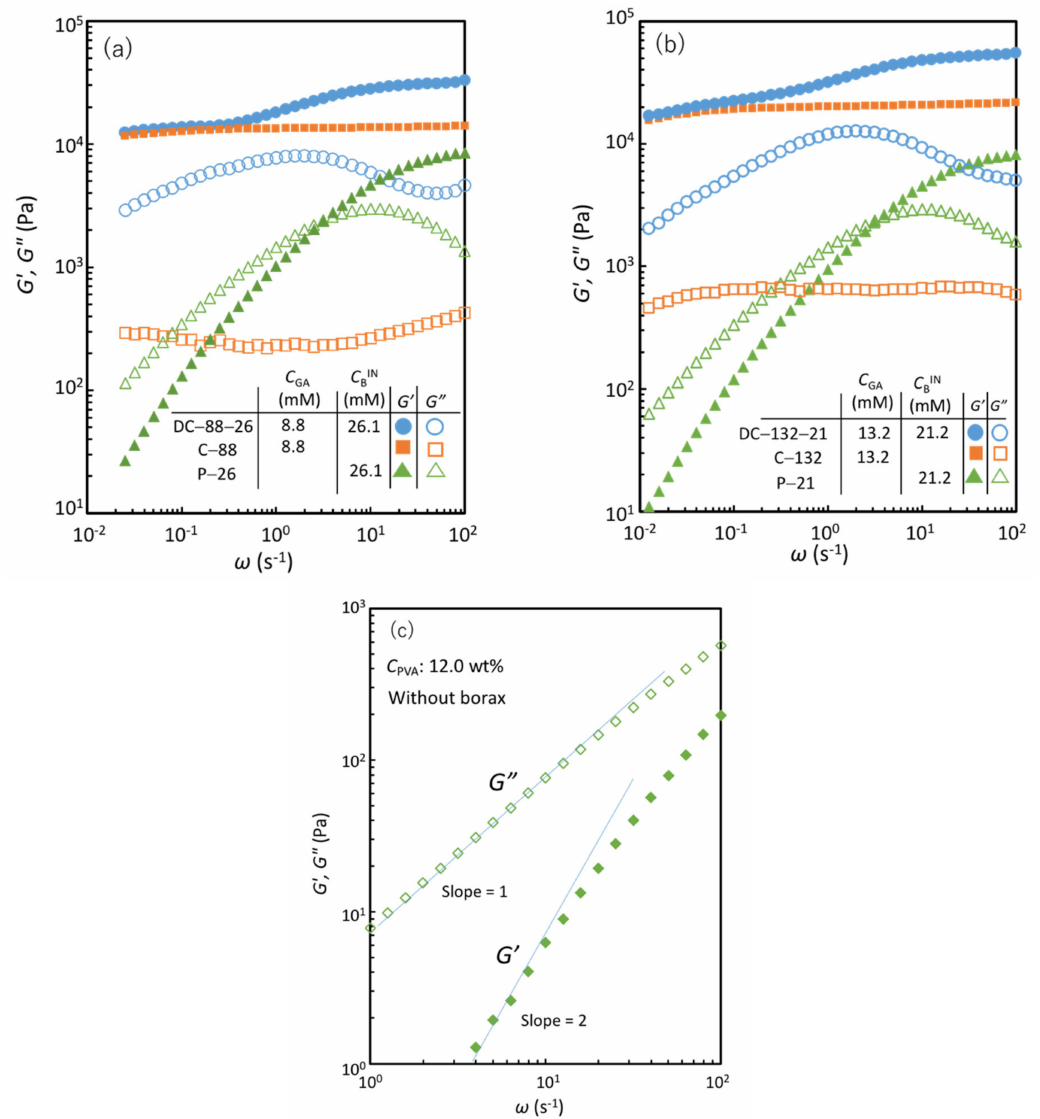
Figure 4. Storage shear modulus ( G (cid:48) ) and loss shear modulus ( G (cid:48)(cid:48) ) as a function of angular frequency ( ω ) for ( a ) DC-88-26, C-88, P-26, ( b ) DC-132-21, C-132, P-21, and ( c ) a PVA solution of C PVA = 12.0 wt% without